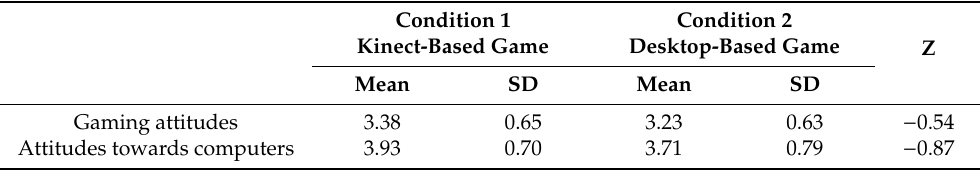
Table 2. Baseline assessment of gaming attitudes and attitudes towards computers per